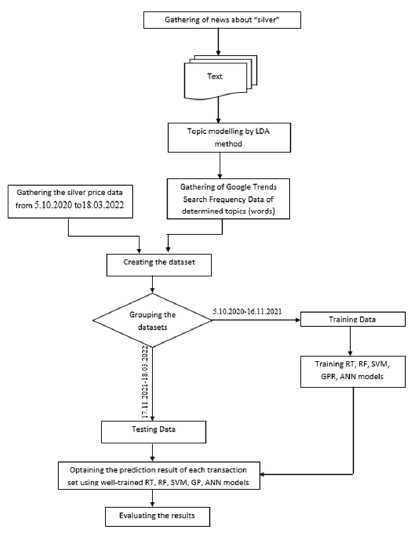
Fig. 2. Process Flow Diagram of The Proposed